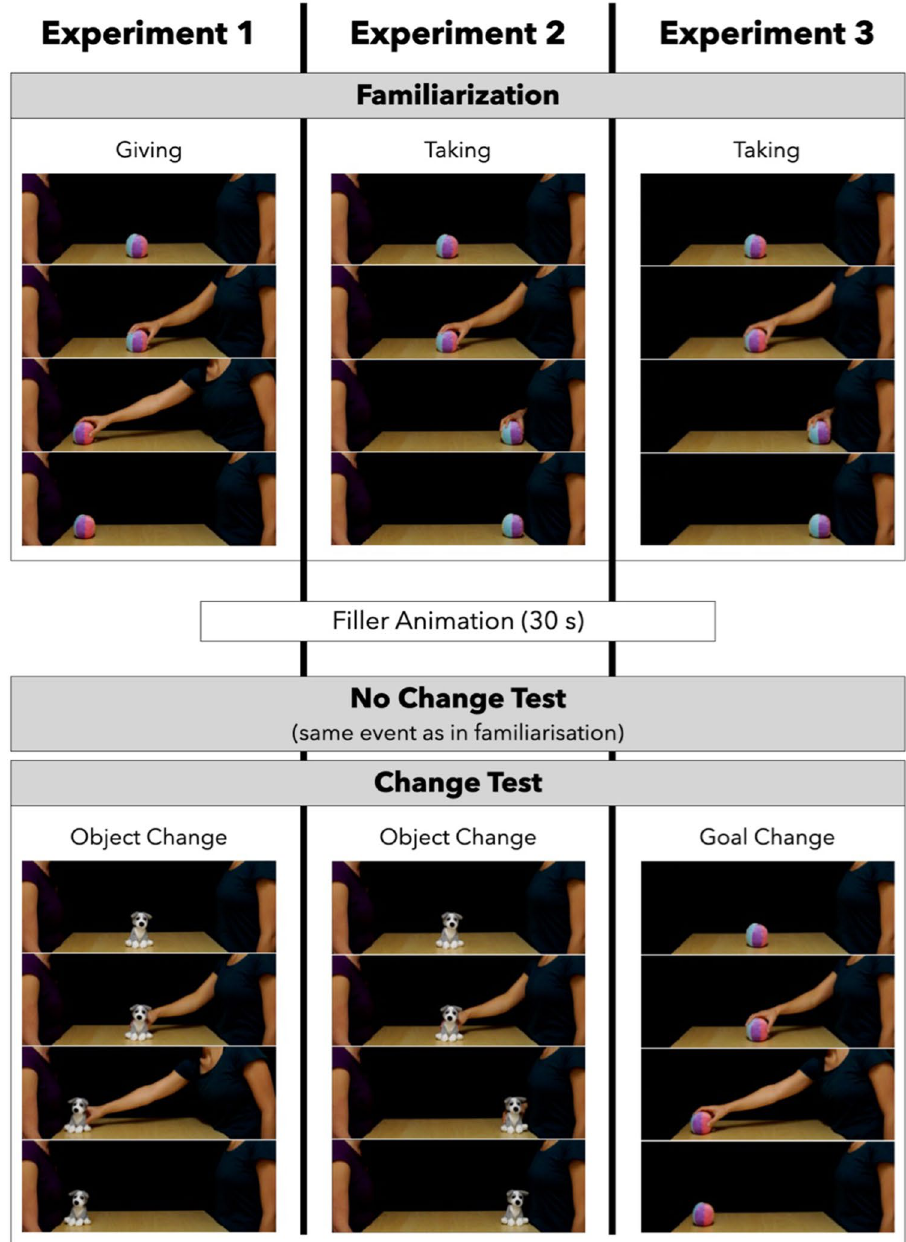
Figure 1. Schematic visualization of the events shown in Experiments